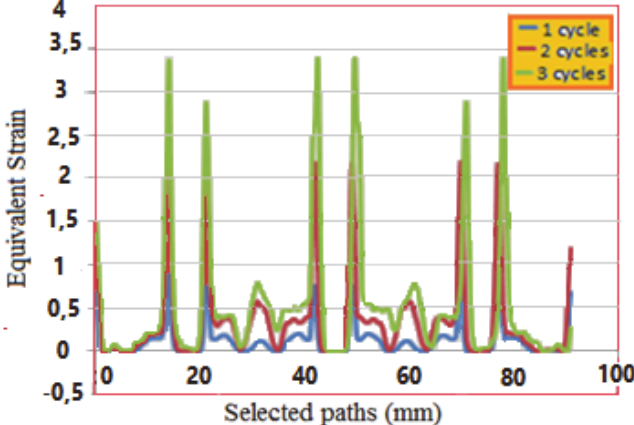
Figure 10: Influence of the number of cycles on the evolution of the plastic strain at the level of the upper